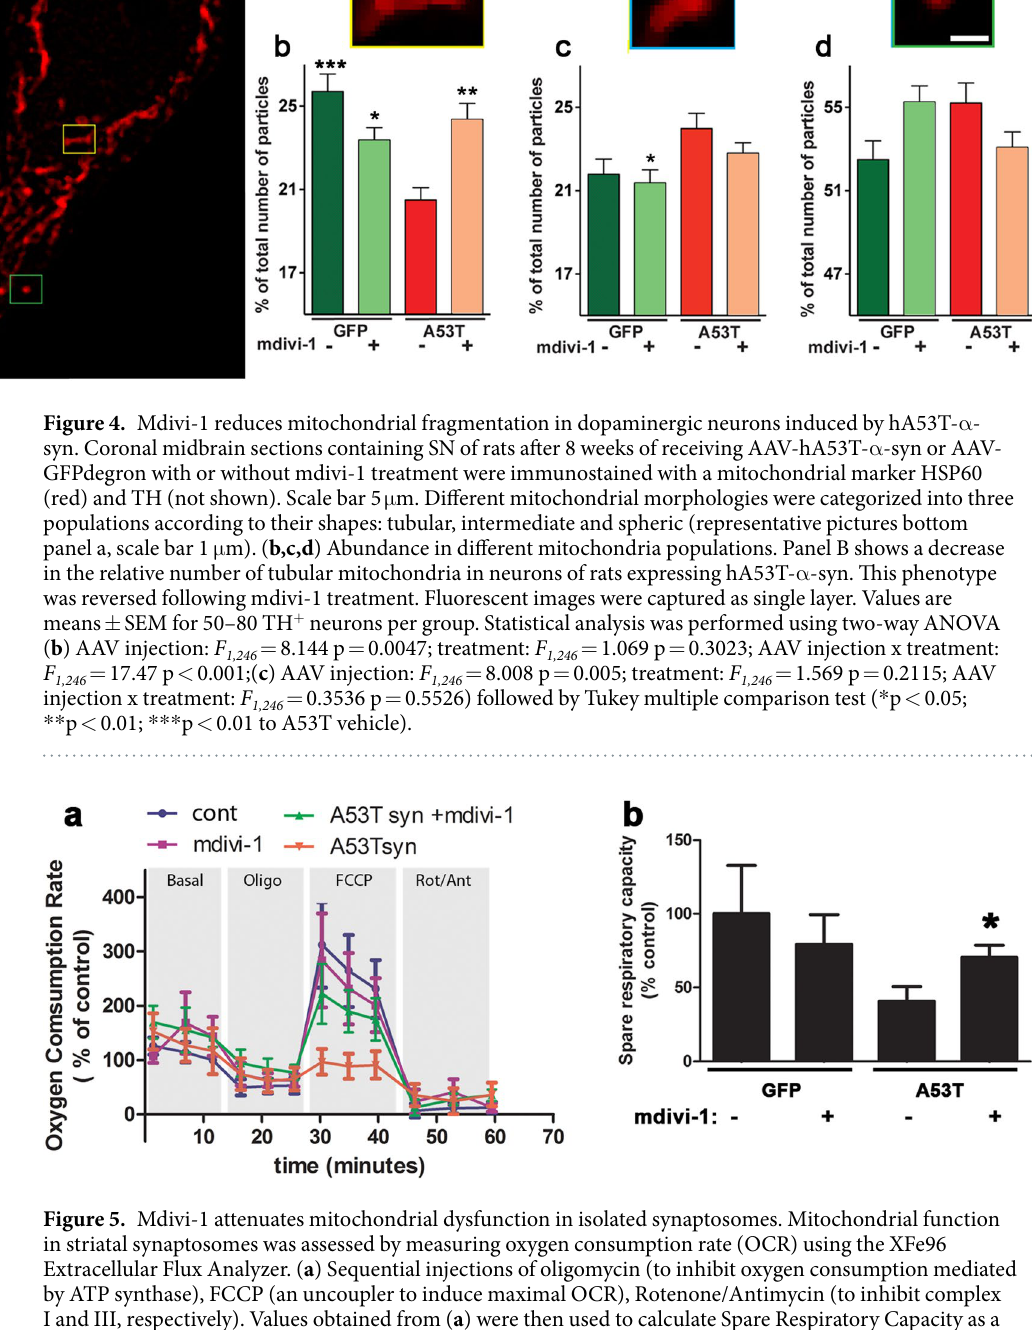
6 SCIeNtIfIC RePoRtS | 7: 7495 | DOI:10.1038/s41598-017-07181-0